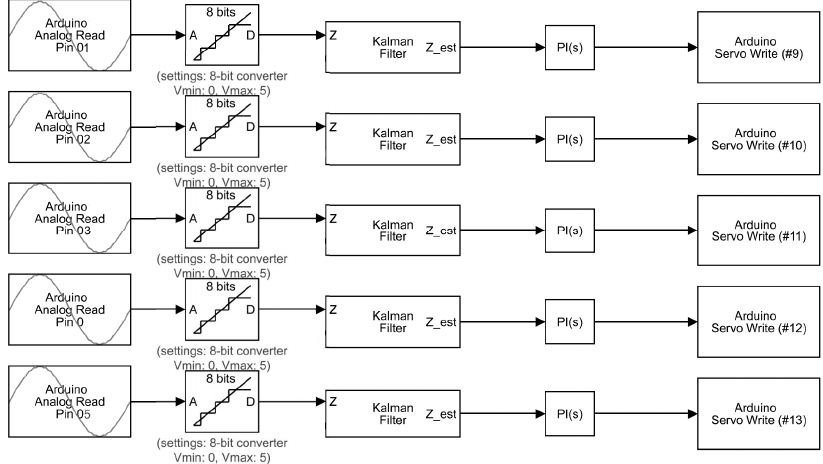
Figure 15. Control algorithm of the flex sensors implemented on Mega Pro.